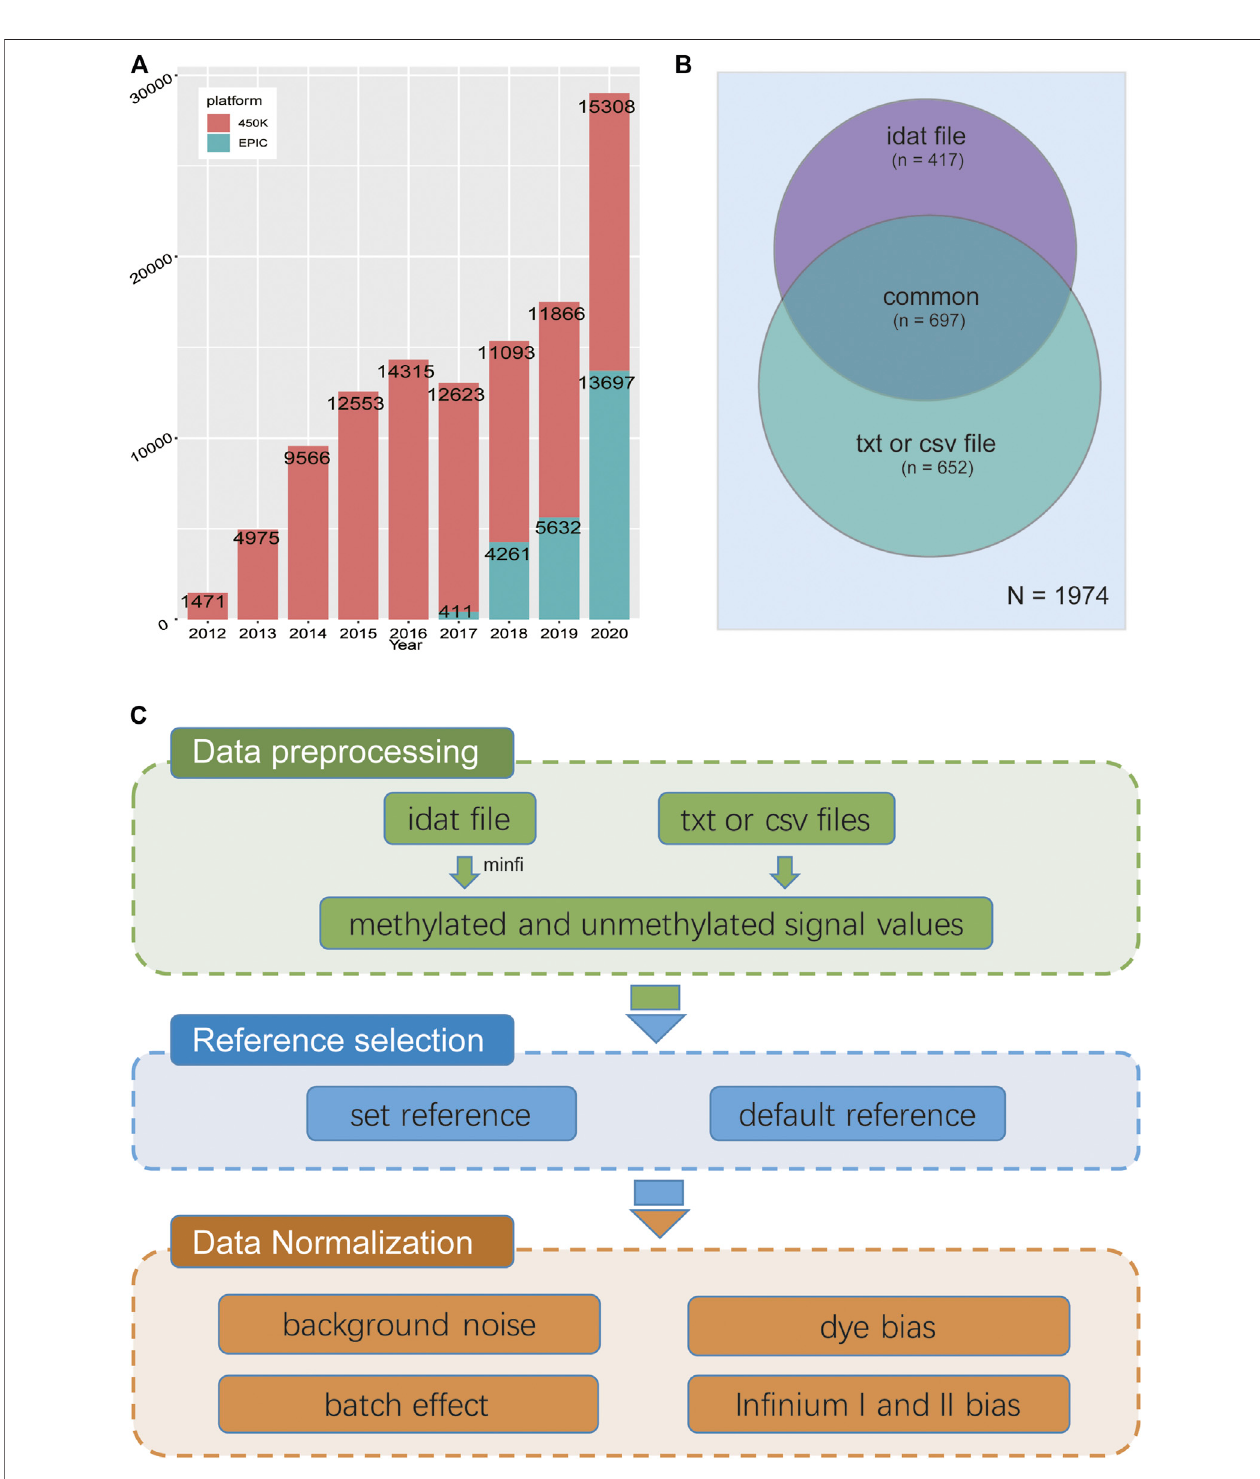
FIGURE 1 | (A) Statistics of 450 k and EPIC data by year and project number in NCBI GEO database. (B) Distribution of data types of DNA methylation chip projects submitted to the GEO database as of December 2020. There were a total of 1,114 items containing the original “ idat ” fi les, and 1,349 items containing TXT or CSV fi les, indicating that most of the items missed original fi le. (C) The work fl ow of GMQN.